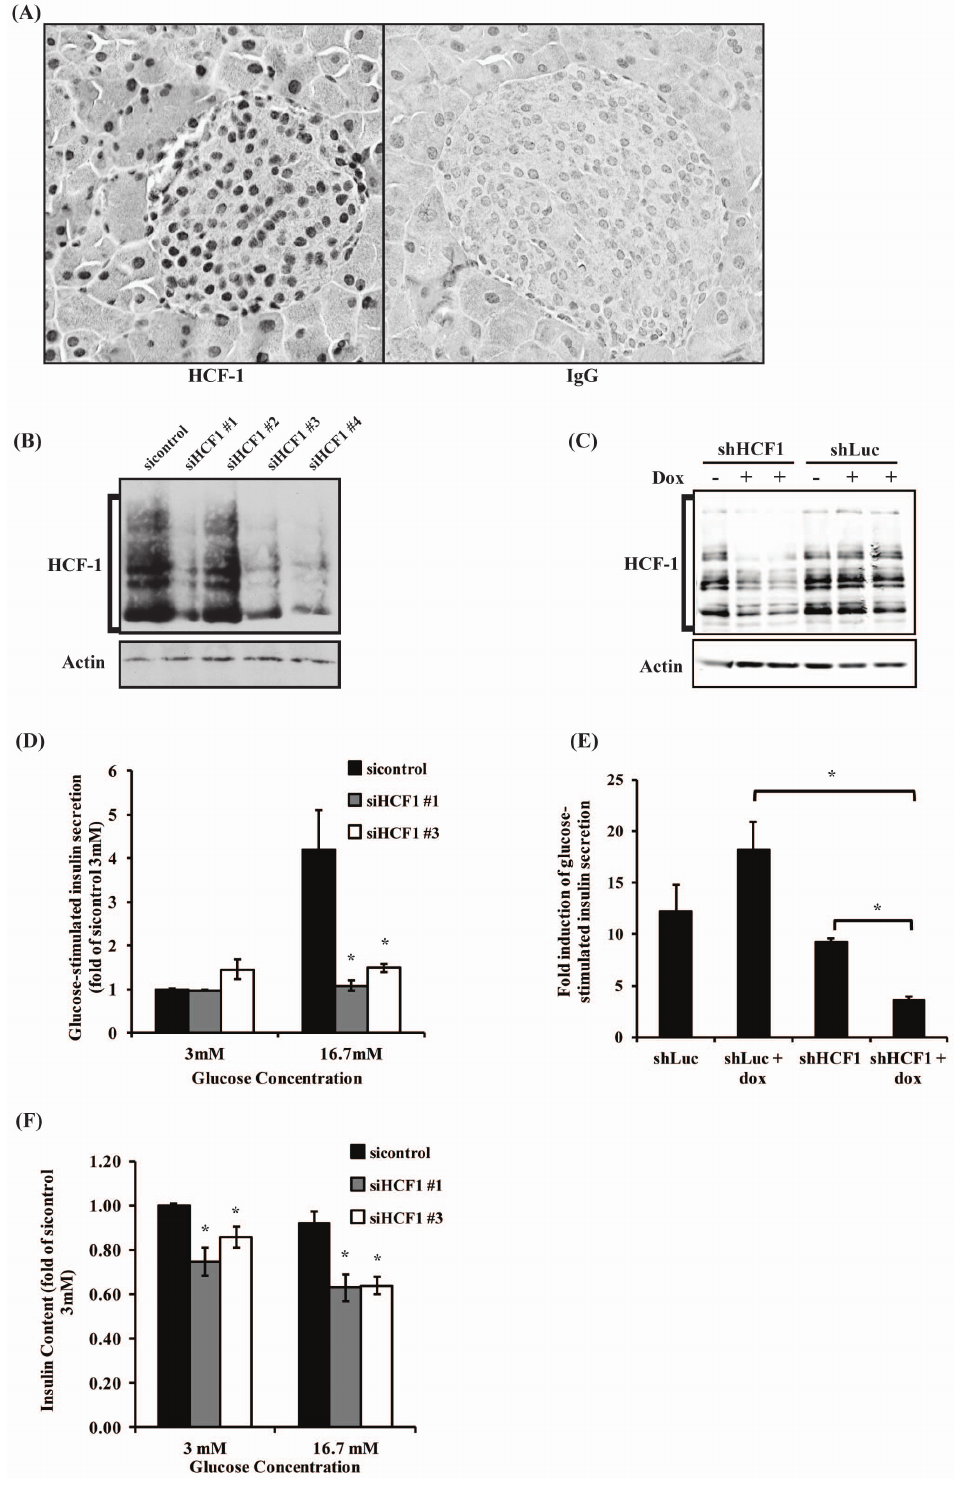
Figure 1. HCF-1 is required for glucose-stimulated insulin secretion. (A) Immunohistochemistry showing HCF-1 expression in mouse pancreas. Pancreas from 6-week-old male C57BL/6 mice was stained with HCF-1 (left panel) or IgG-control (right panel). HCF-1 is expressed in the nuclei of cells from the exocrine pancreas and the islet of Langerhans. (B) Western blot analysis of HCF-1 protein levels from INS-1 cells transfected twice with control or four different HCF-1 siRNAs. (C) Western blot analysis of HCF-1 levels from cells induced to express shLuc or shHCF-1 shRNA with doxycycline treatment. (D) Glucose-stimulated insulin secretion analysis of cells treated with HCF-1 siRNA. Insulin secretion determined by insulin ELISA and normalized to total cellular protein. Results shown are pooled from three independent experiments, and represent mean + / 2 SEM. *denotes a p-value , 0.05 relative to sicontrol (Student’s t-test). (E) Glucose-stimulated insulin secretion of INS-1 cells expressing shLuc or shHCF1